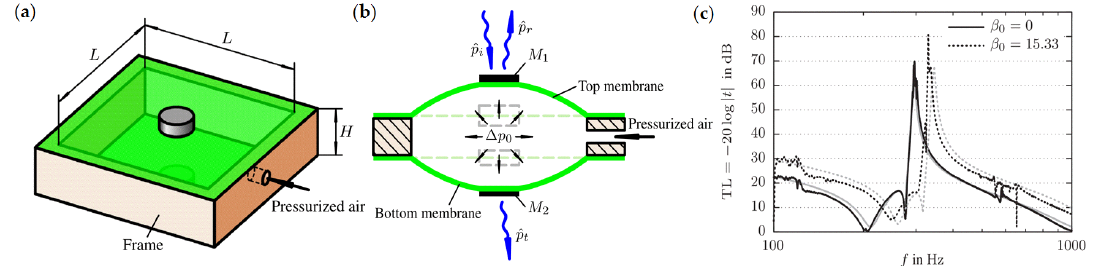
Figure 5. A unit cell of the proposed active AMMs (AAMM) with an inflatable double membrane AMM element. ( a ) Isometric view of the square AAMM unit cell; ( b ) Cross-sectional view through the AAMM unit cell; ( c ) Experimental and theoretical normal sound transmission loss (STL) for the